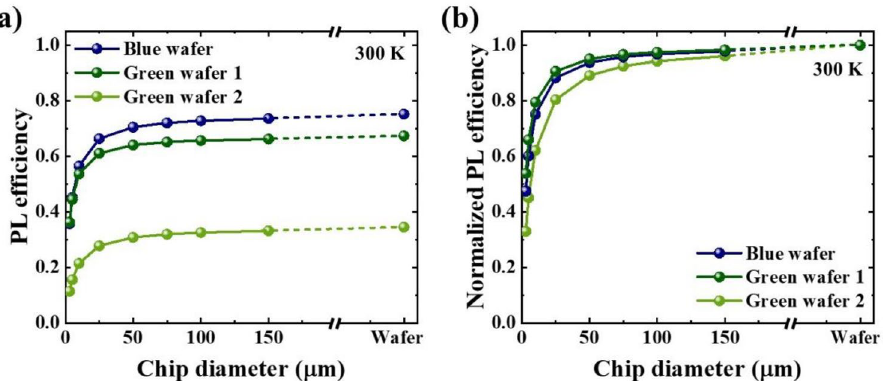
Figure 2. ( a ) Chip diameter dependence of PL efficiencies at room temperature for three examined LED wafers. The PL efficiencies were estimated by the intensity ratio between 20 and 300 K. PL efficiencies of bare wafers are shown together to compare PL efficiencies before and after chip fabrication process. ( b ) Chip diameter dependent PL efficiencies of the three LED wafers normalized by the PL efficiencies of each bare wafer.